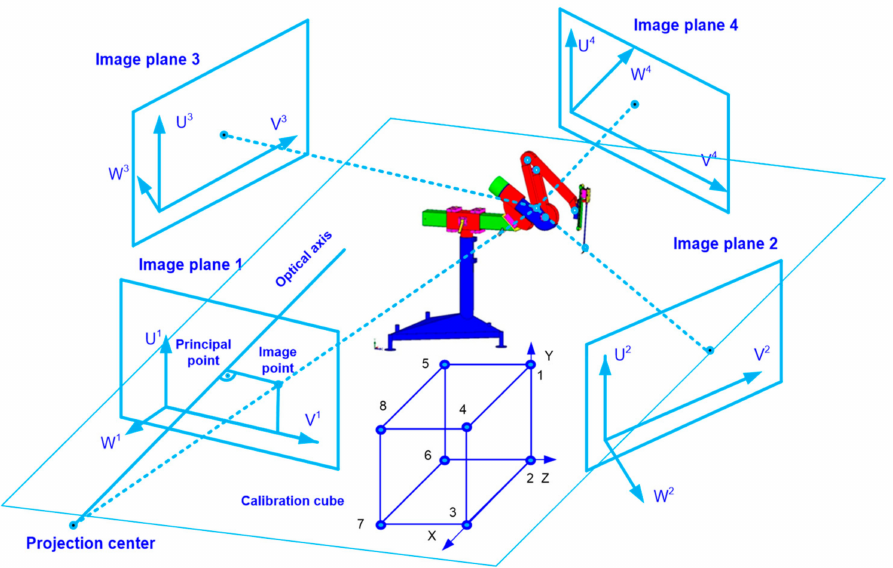
Figure 8. The layout of the experiment. It involves a system of four CMOS optical sensors, a calibration cube, and the surgical robot “Robin Heart 1” as the object of the experiment. The parameters of DLT algorithm are marked on the image plane of every CMOS